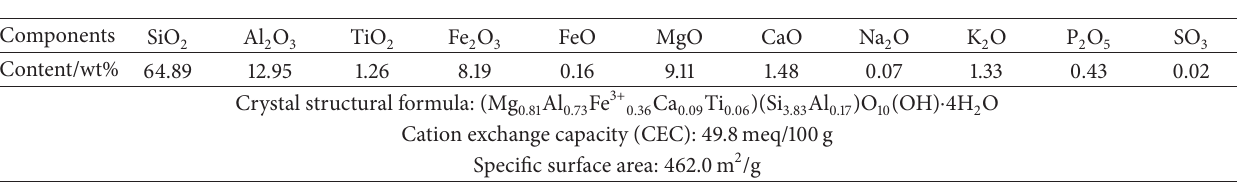
Al O TiO Fe O FeO MgO CaO K 2 2 3 2 2 3